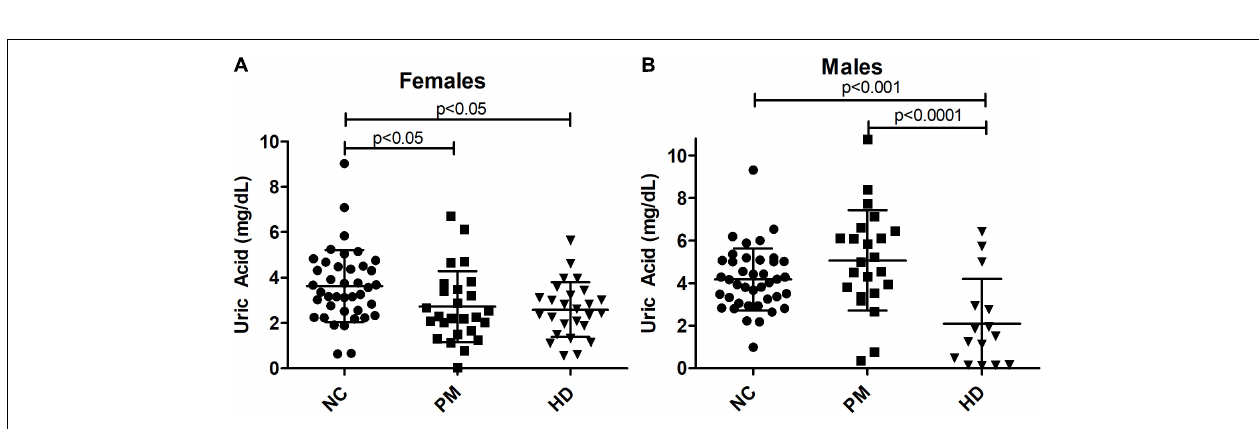
FIGURE 3 | Gender and age effects of uric acid (UA) in saliva from Huntington’s disease (HD) patients and normal controls (NC). (A) UA levels were significantly higher in males compared to females in both NC and HD groups. The HD group also included pre-HD patients (PM). Significant differences were determined by Student’s t -test, unpaired; two-tailed; p = 0.05; p = 0.003. (B) No significant effects of age on salivary UA levels were observed in any group.